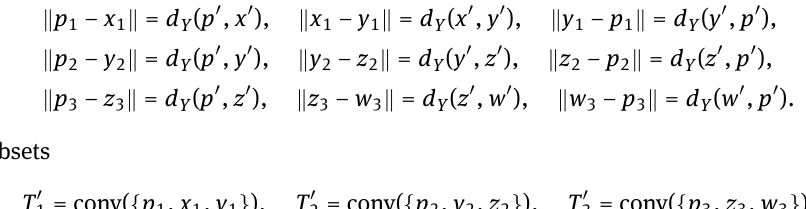
into ˜ Y is clearly an isometric embedding. i